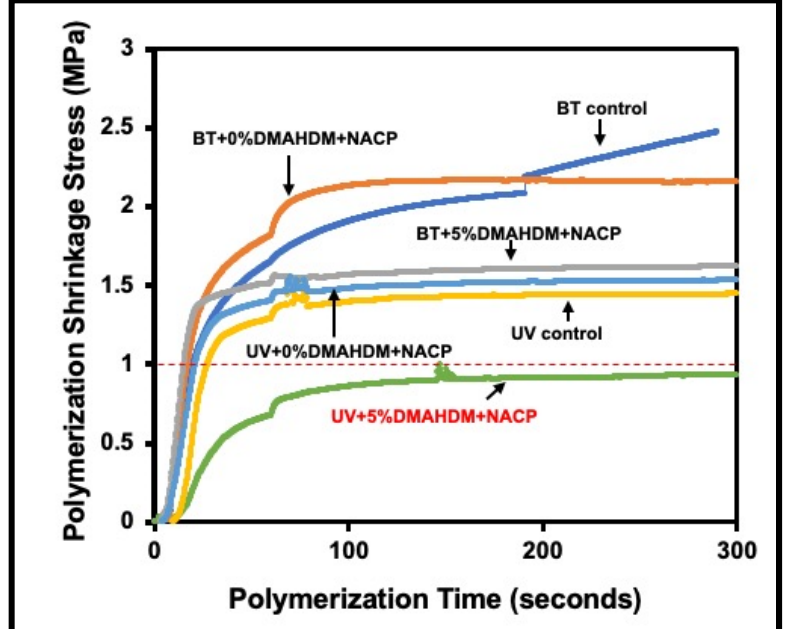
Figure 4. Polymerization shrinkage stress vs. polymerization time ( n = 3). The low-shrinkage-stress UV resin composite groups showed delayed development of polymerization stress and lower shrinkage stresses ( p < 0.05) compared to BisGMA + TEGDMA (BT) groups. (Dark blue curve: Experimental control resin composite: 35% BT + 65% glass (denoted as BT control), Orange curve: 35% BT + 0% DMAHDM + 20% NACP + 45% glass (denoted as BT + 0%DMAHDM + NACP), Gray curve: 30% BT + 5% DMAHDM + 20% NACP + 45% glass (denoted as BT + 5% DMAHDM + NACP), Yellow curve: Experimental control resin composite: 35% UV + 65% glass (denoted as UV control), Light blue curve: 35% UV + 0% DMAHDM + 20% NACP + 45% glass (denoted as UV + 0% DMAHDM + NACP), Green curve: 30% UV + 5% DMAHDM + 20% NACP + 45% glass (denoted as UV + 5% DMAHDM + NACP)), Adapted with permission from reference [114]. Copyright 2021 Elsevier.